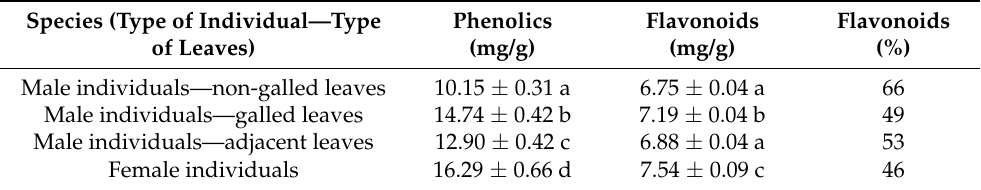
Table 1. Total contents of phenolics and flavonoids from samples of different types of leaves in both sexes of C. fluminensis. Numbers are the mean value of the metabolite class (mg/g; dry mass) and the standard deviation. Means with different letters within a column are significantly different at the 0.05 probability level (ANOVA and post-hoc Tukey